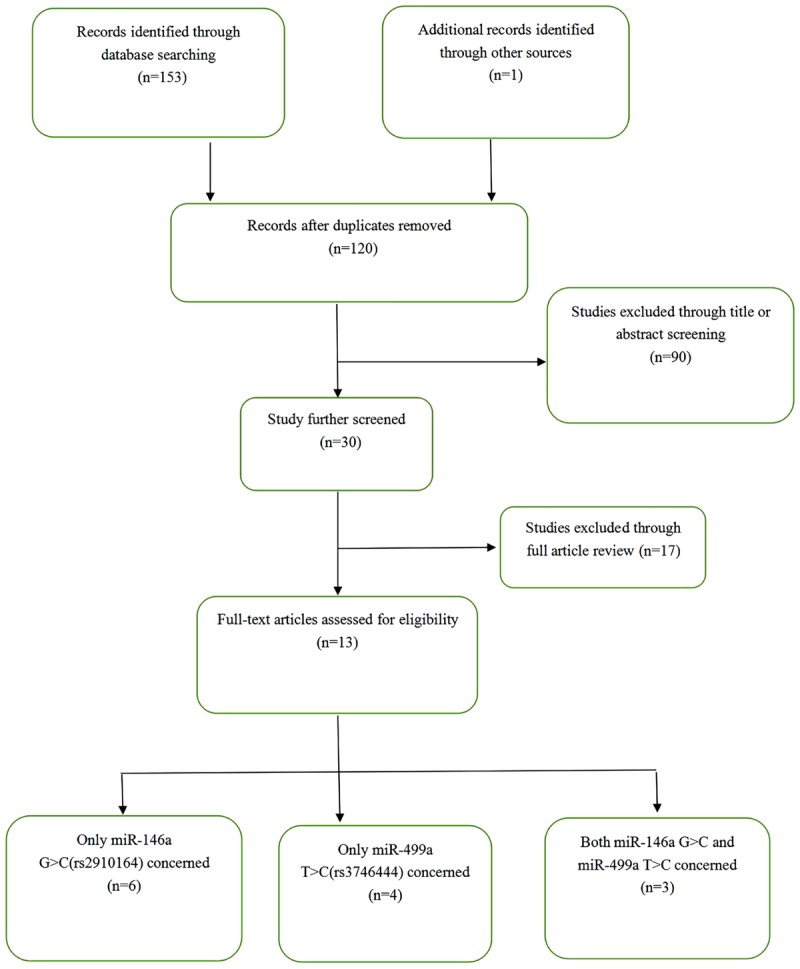
Flow chart showing the detailed steps for literature selection.